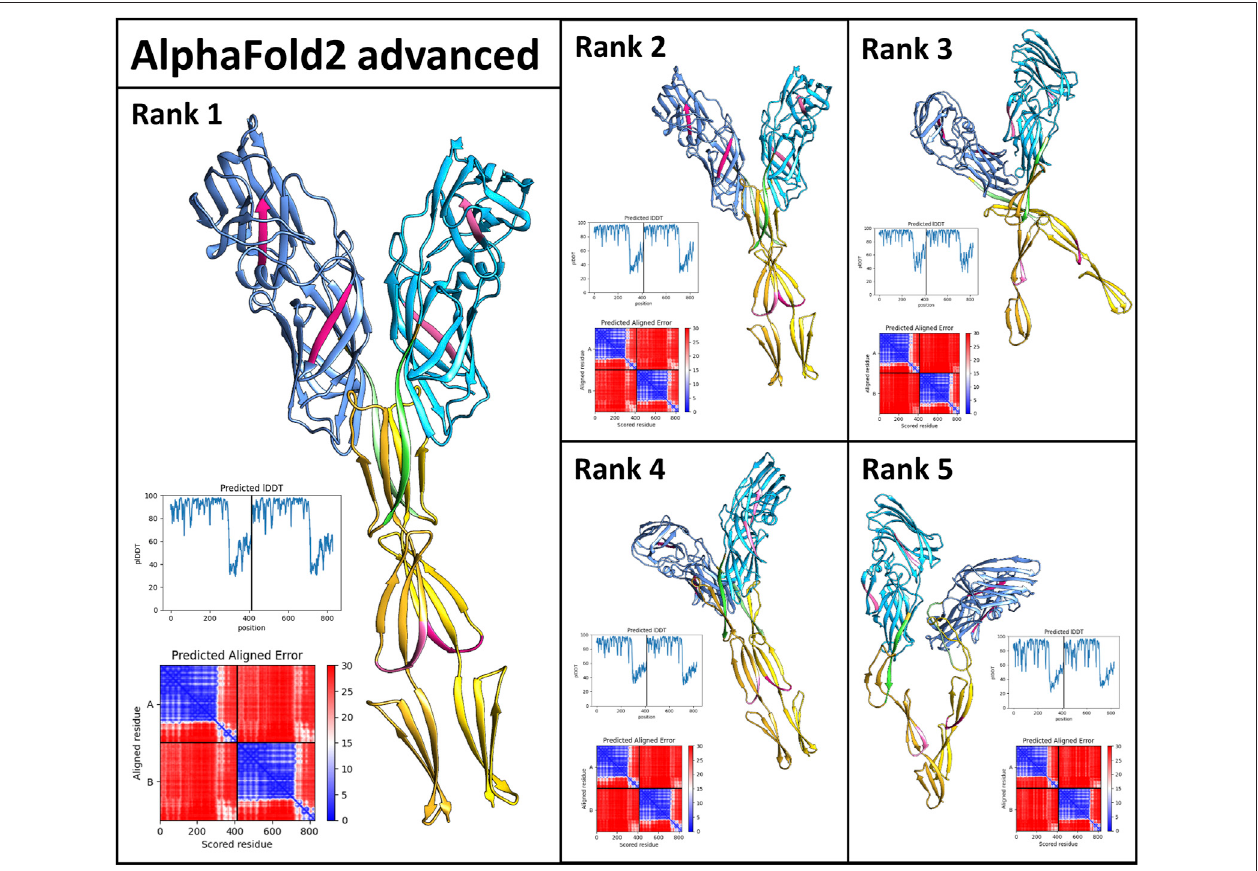
FIGURE6| AlphaFold2_AdvancedmodelsofAls5dimers.ThemodelisbasedonthesequencesoftheIg/Tdomains,coloredasin Figure1 .Therankingisbased on AlphaFold con fi dence score. The scores are quanti fi ed by the graphs showing the con fi dence score lDDT plotted against the sequence and the alignment plots (Mariani et al.,